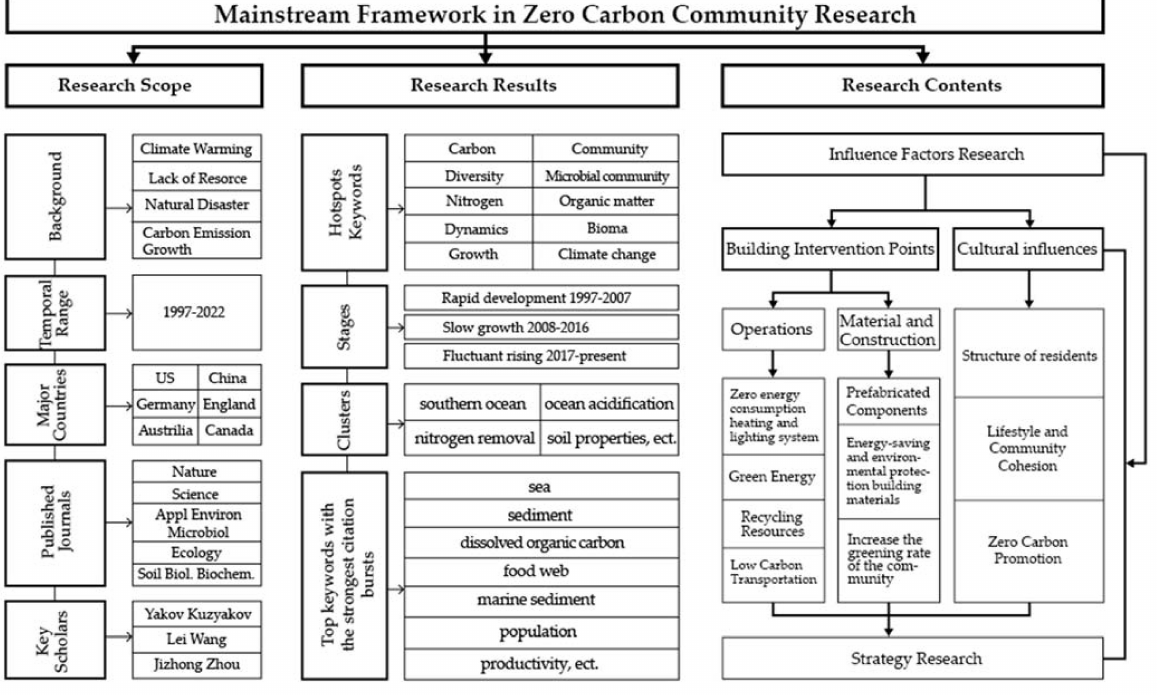
Figure 12. Mainstream framework in ZCC